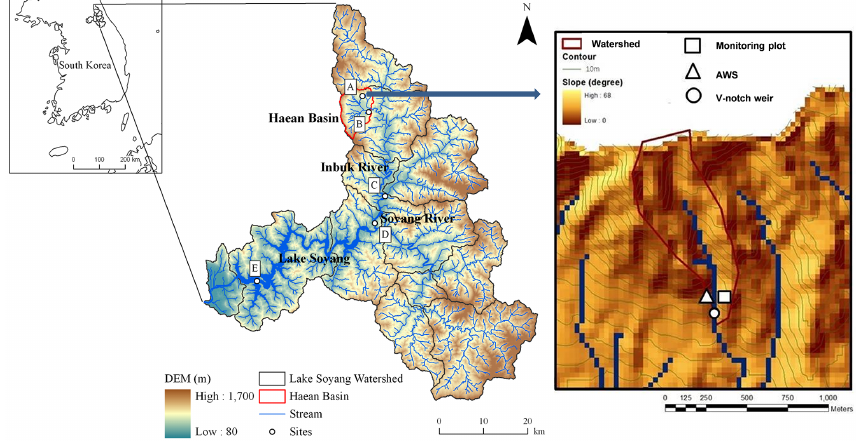
Figure 1. Monitored headwater watershed (right) within the Haean Basin in the Lake Soyang watershed, South Korea (left; “A” indicates the location of the headwater watershed in the Haean